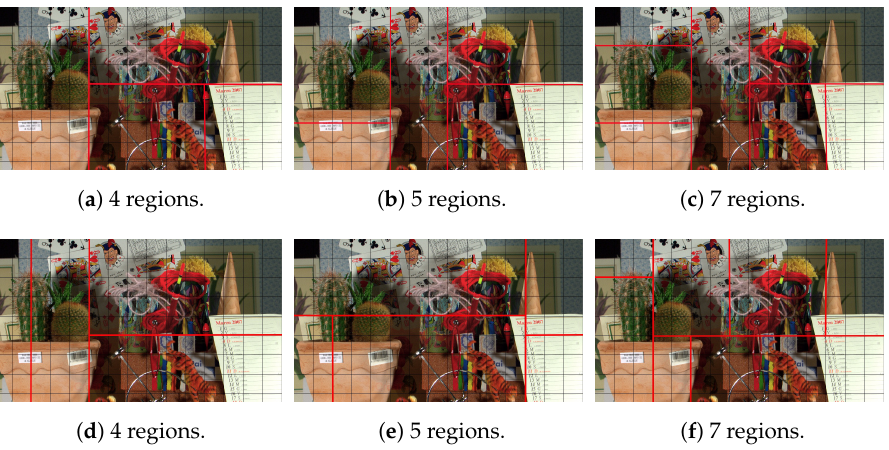
Figure 7. Cactus video sequence: ( a – c ) Serial Region Growing, ( d – f ) Concurrent Region